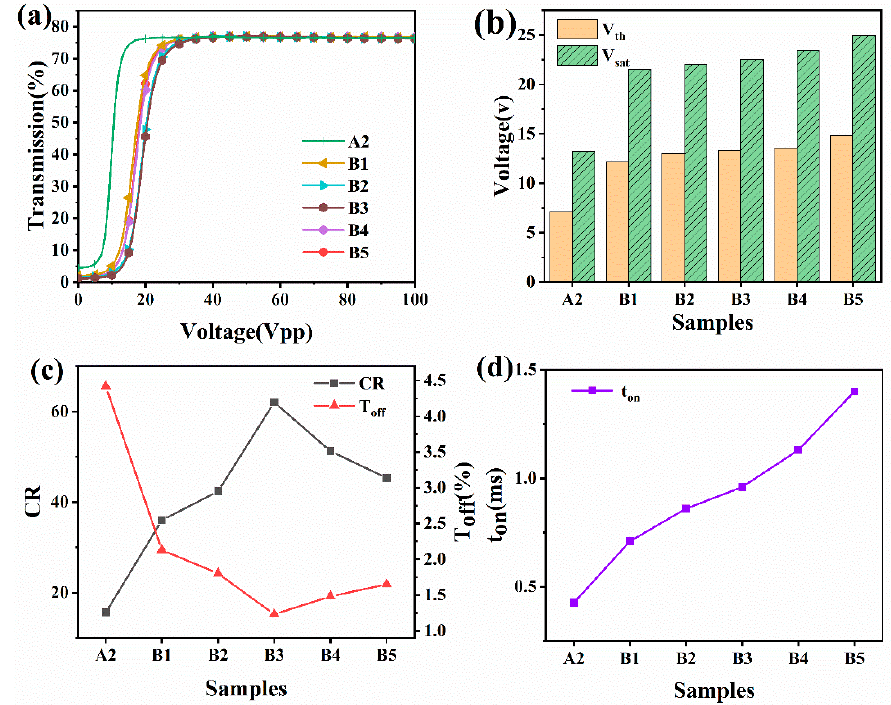
Figure 6. ( a ) Species’ transmittance varies depending on A2 and B1–B5 on the applied electric field (100 Hz); ( b ) off-state emissivity and comparison ratio of recordings A2 and B1–B5’s; ( c ) saturation and threshold voltages for recordings A2 and B1–B5’s; and ( d ) reaction times for recordings A2 and B1 through B5.